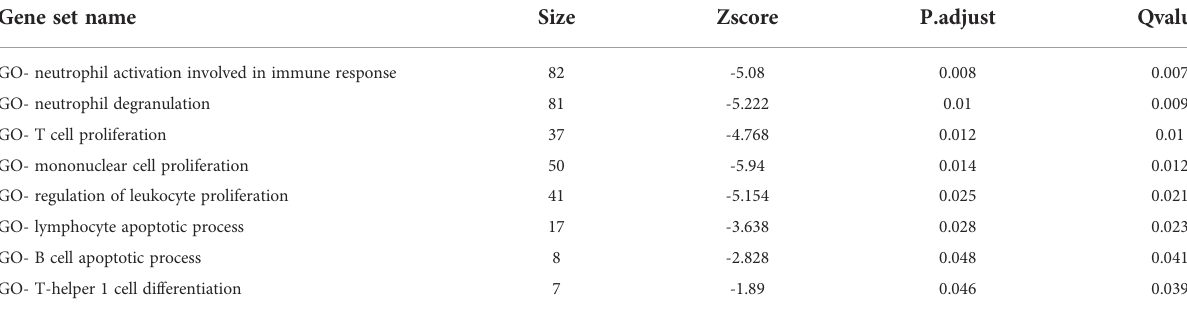
TABLE 3 Immunologic signature associated biological processes enriched in DEGs